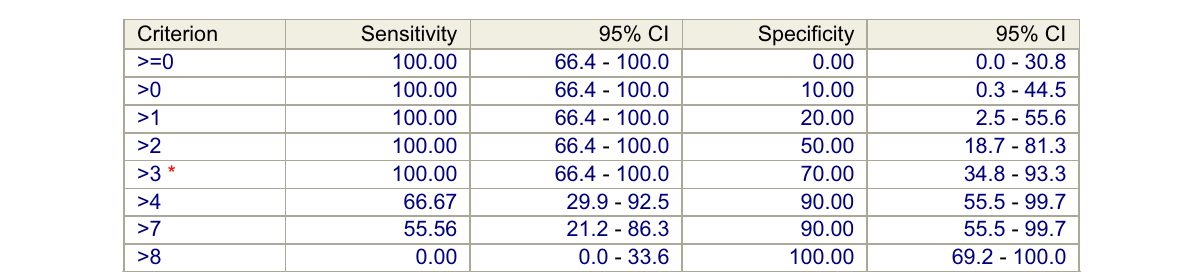
Fig. 3 Receiver operative characteristic (ROC) curve for EVLW/kg